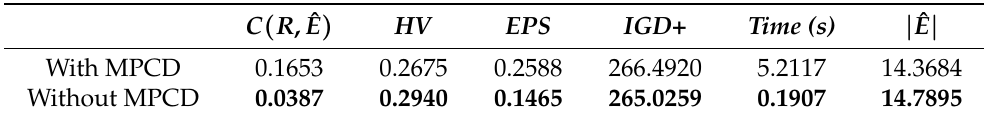
Table 5. Comparison between the approximation fronts obtained by including and excluding the MPCD greedy function in the construction